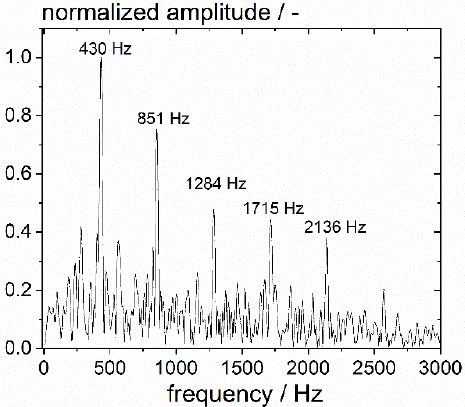
Figure 4. Time evolution of white pixel area during atomization at n = 10 krpm and (cid:1848)(cid:4662) = 350 mL/min. Red line represents mean value.